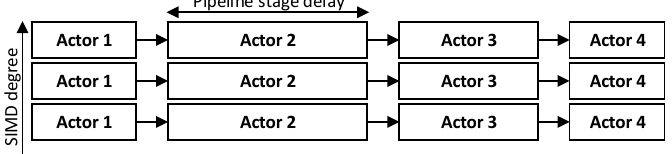
Figure 2. Illustration of possible data and task parallel decomposition of a dataflow algorithm found in image processing designs where the numerous of rows indicate the level of parallelism.